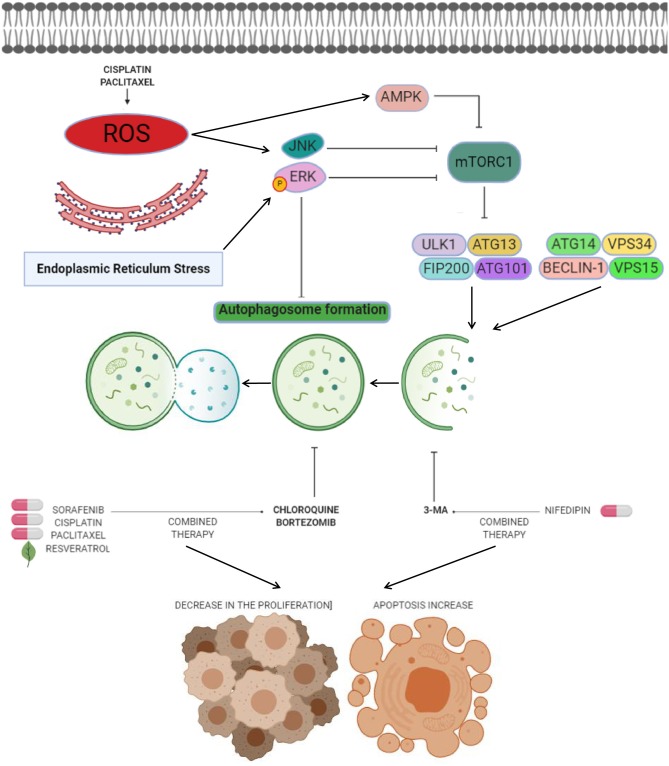
Anti-autophagic approaches in endometrial cancer. Anti-autophagic chemicals (bold letters), autophagy inducing chemicals (pills), or natural compounds (leaf) tested in endometrial cancer cells. The production of reactive oxygen species (ROS) after cisplatin and paclitaxel therapies mediates the autophagy process. ROS have been shown to induce autophagy by several processes including activation of ERK and JNK transducers, as well as inhibition of mTOR signaling by AMPK. Novel strategies for therapeutic intervention in endometrial cancer are based on the suppression of autophagy through use of agents such as CQ or 3-MA to promotes cell death and decreases in cell proliferation when combine with agents like sorafenib, cisplatin, paclitaxel, resveratrol, and nifedipin. Other agents such as bortezomib block cisplatin-induced autophagy and stimulate the cytotoxic effects of chemotherapy on cancer cells.